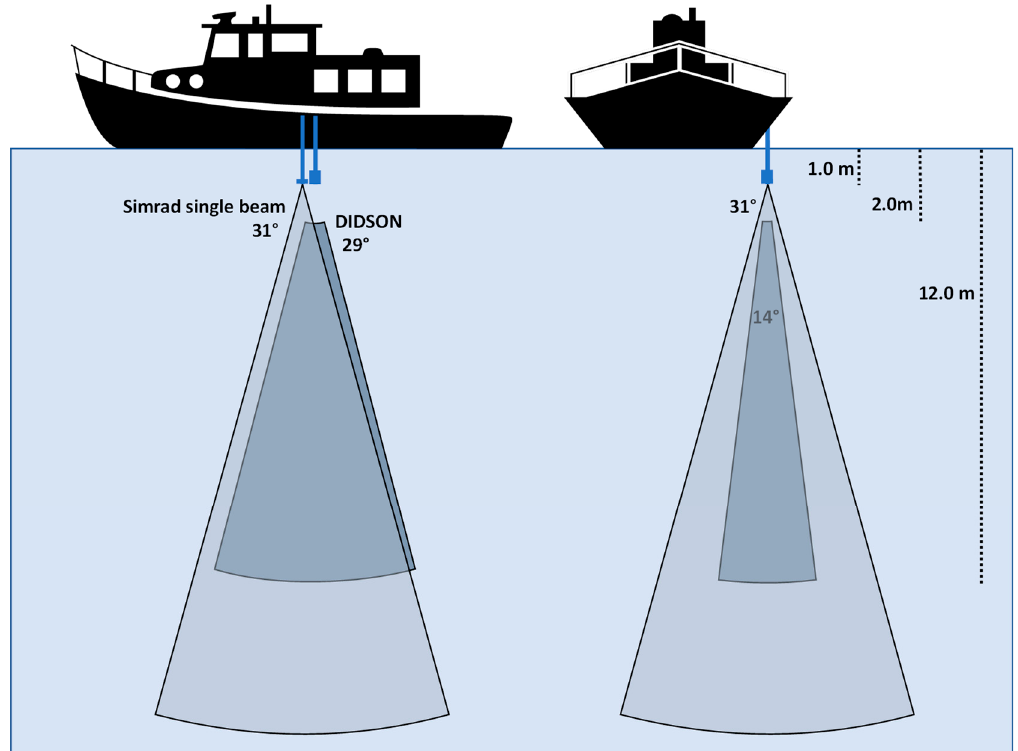
Figure 2. Schematic of the deployment of the Simrad single beam echosounder and the DIDSON acoustic camera. Both units were 1 m below the surface and the DIDSON was 0.31 m aft of the Simrad. The DIDSON unit begins data collection 1 m deeper than the location of the instrument. The single beam echosounder has a circular, roughly conical beam of 31°, while the DIDSON has a roughly rectangular frustum beam that is 14° by 29°.